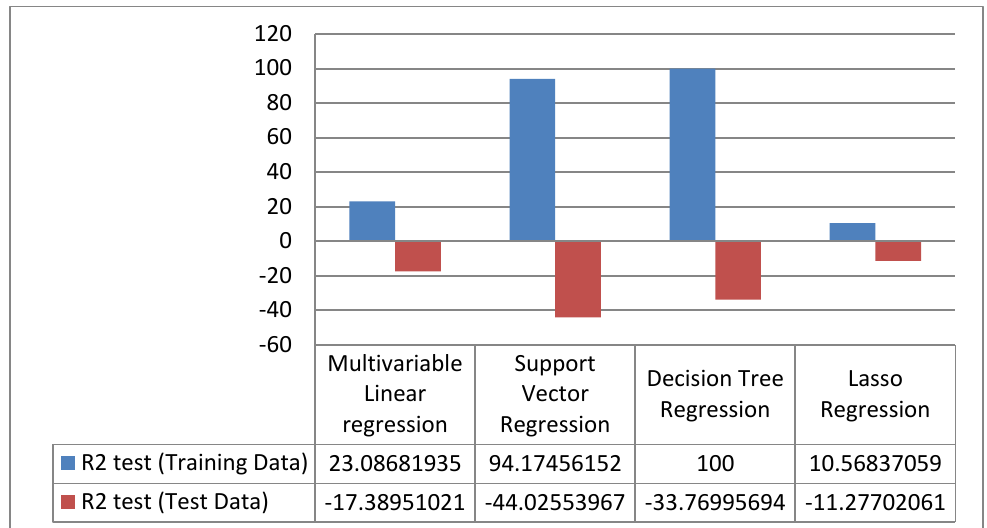
Figure 6. R 2 result for Turbidity.